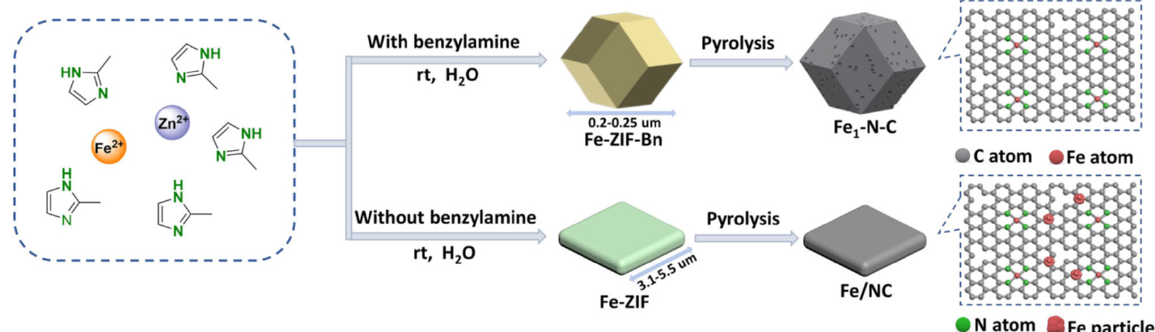
Figure 12. The preparation procedure for Fe 1 -N-C catalyst. Reprinted with permission from Ref. [39]. Copyright © Springer Nature 2022.